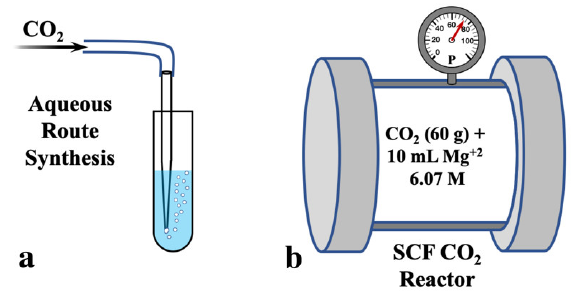
Figure 1. Schematic diagrams showing the experimental method for aqueous synthesis, ( a ) bubbling CO 2 gas, and ( b ) supercritical fluid (SCF) closed reactor (kept at constant temperature in a hot water bath, not shown for clarity).